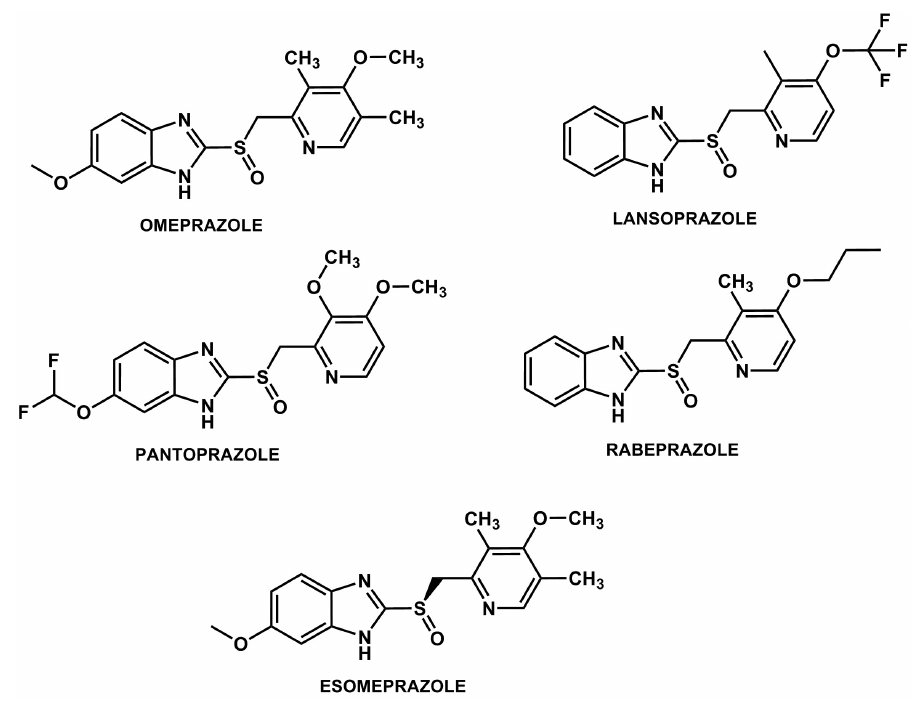
FIGURE 11 - The main gastric H + /K + ATPase